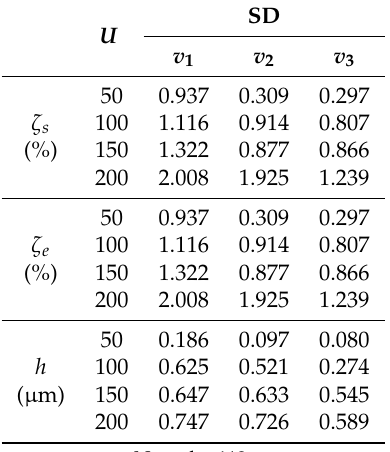
Table 5. Standard deviation of micro